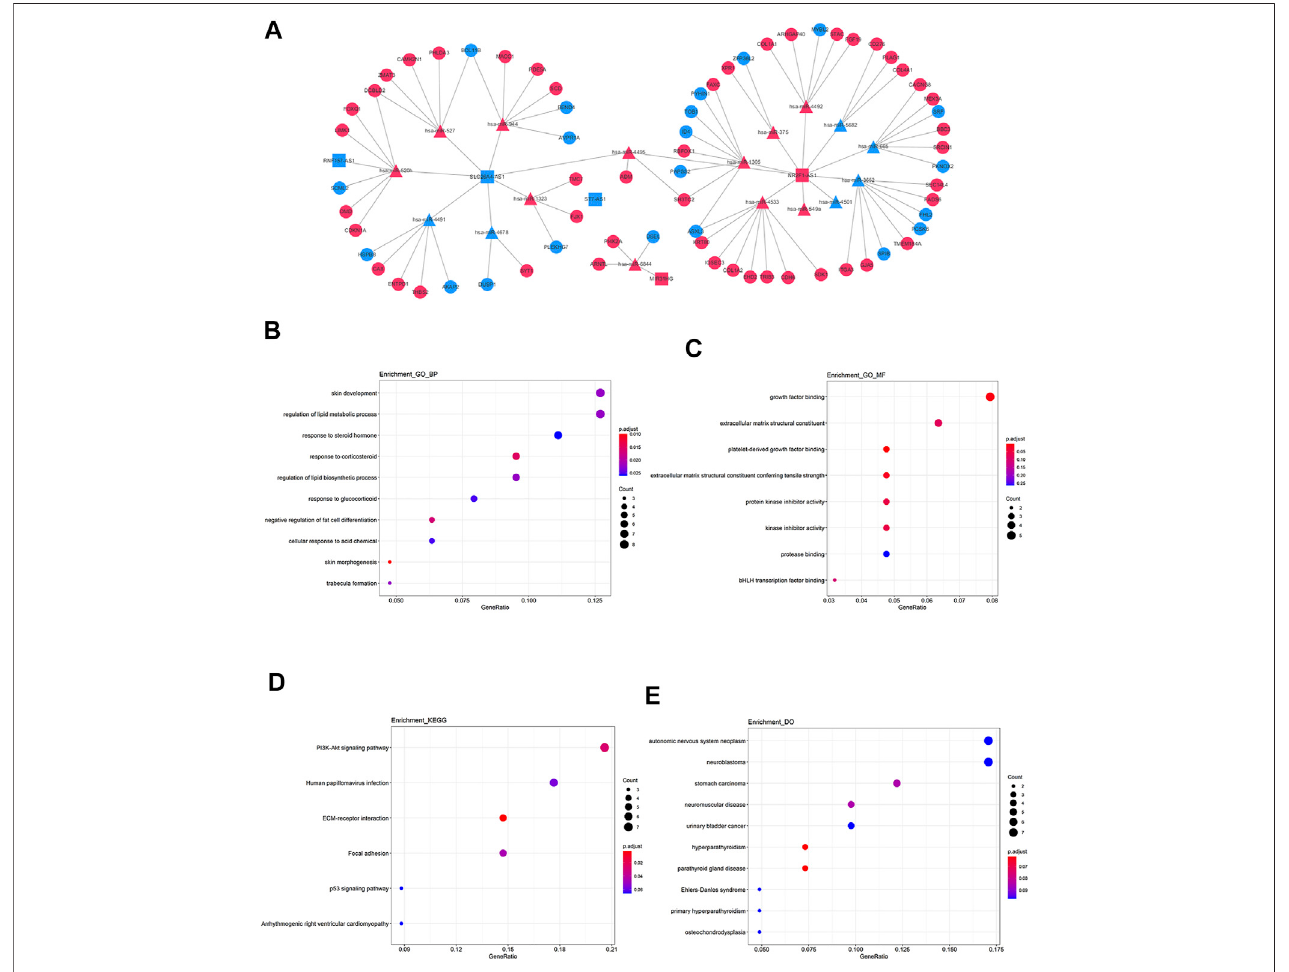
FIGURE 6 | | lncRNA-miRNA-mRNA ceRNA network and functional prediction of mRNAs in network. (A) The network consists of three lncRNAs (rectangles), 17miRNAs(triangles),and68mRNAs(circles).Theredpotsrepresentup-regulatedRNAsandthebluepotsrepresentdown-regulatedRNAs. (B) Thebiologicalprocess items by GO analysis. (C) The molecular function items by GO analysis. (D, E) Functional enrichment analysis of